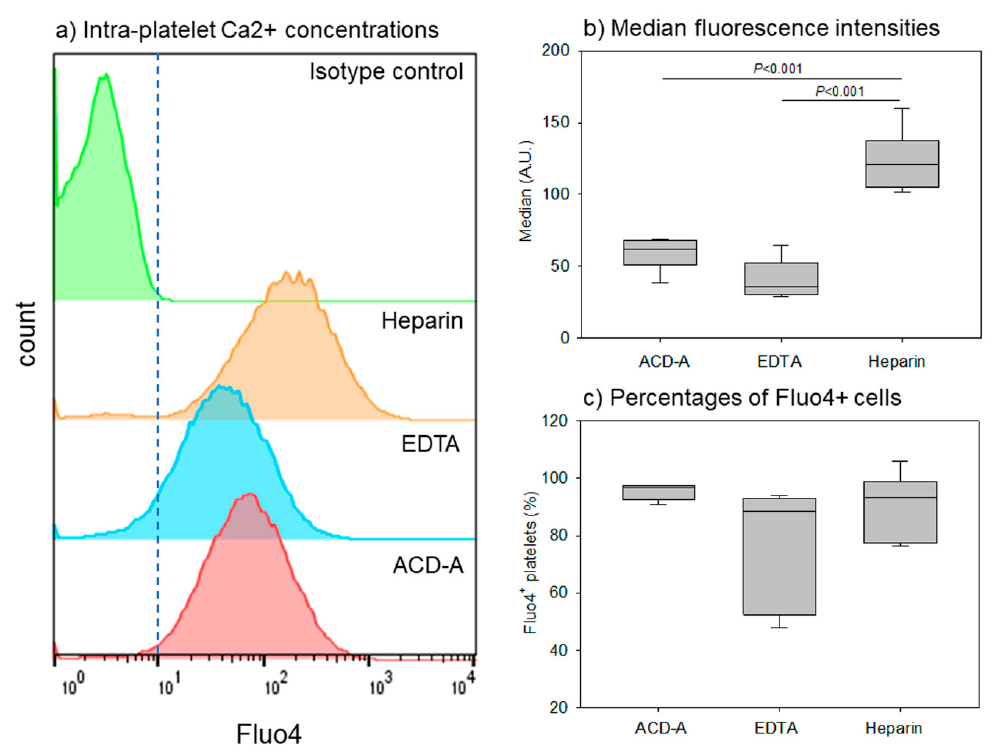
Figure 6. Effects of anticoagulants on intra-platelet free Ca 2+ concentration. Pure-PRP samples were prepared from whole-blood samples stored for 24 h. ( a ) Representative histograms of Fluo4 + platelets. ( b ) Median fluorescence intensities of platelets. ( c ) Percentages of Fluo4 + cells. n = 6.